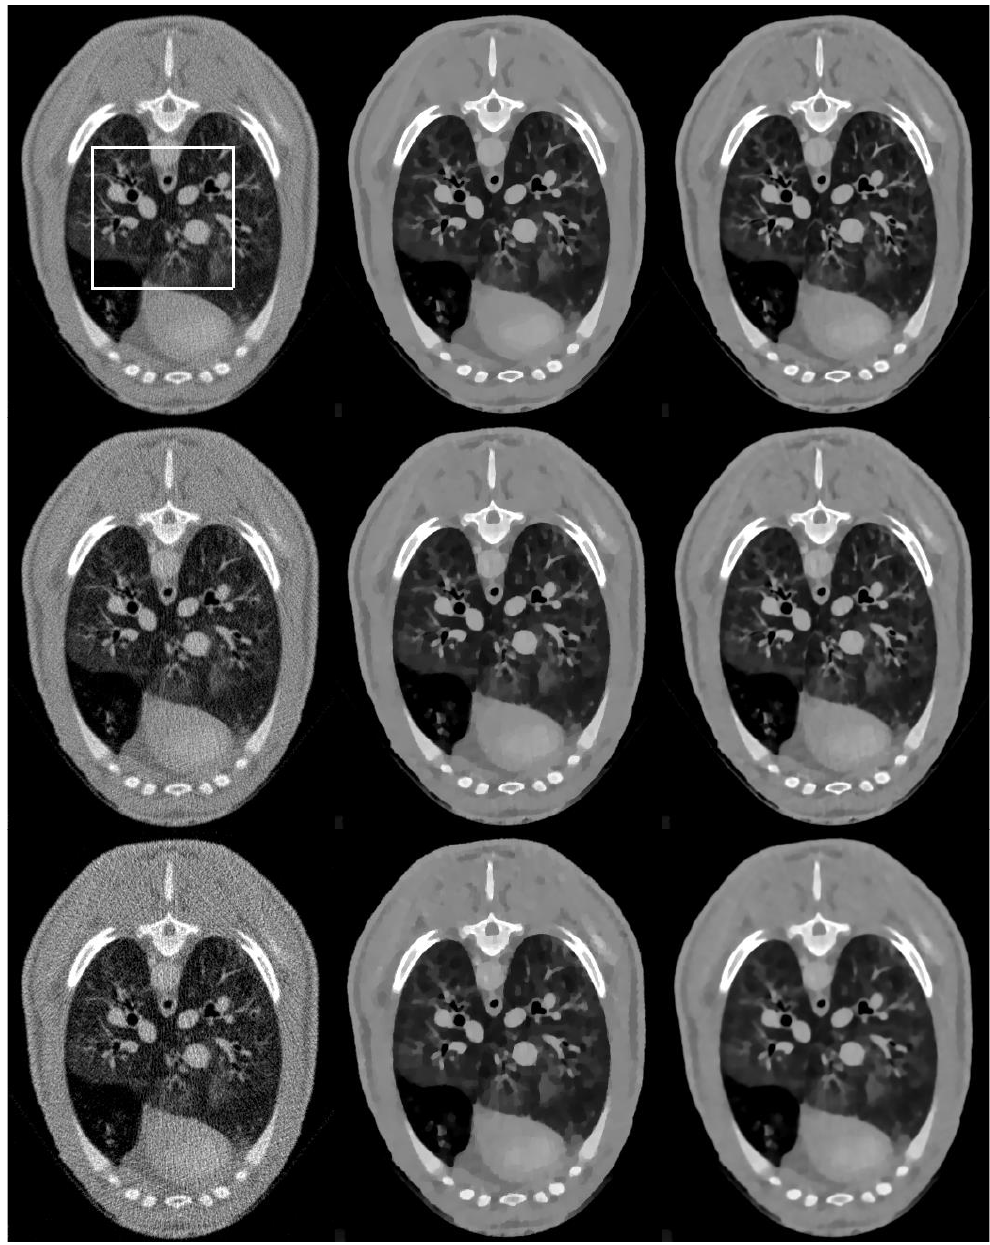
Figure 10. Images reconstructed by the FBP (left column), SIR-TV (middle column), and SIR-STV 1 (right column) methods from low dose projections with 1160 views (the first row), 580 views (the second row, and 290 views (the third row). The display window is [–1000, 800] HU.